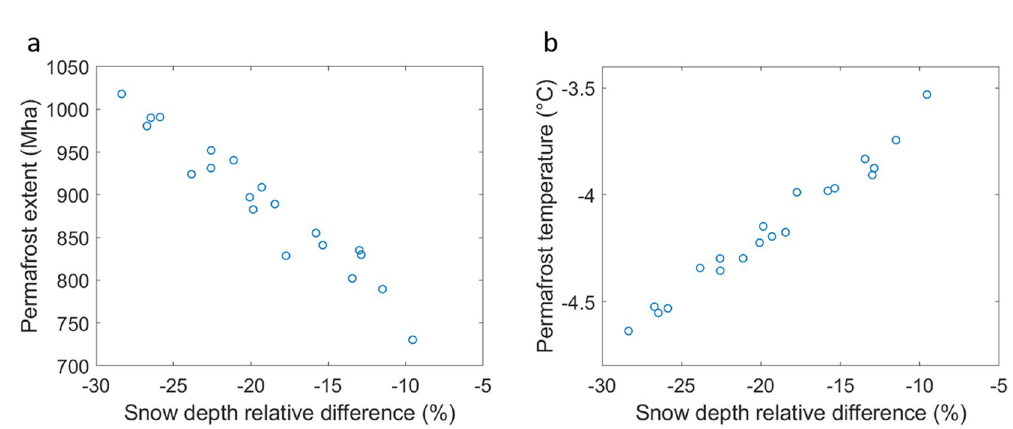
Figure 6. Sensitivity study mean areal results of permafrost extent ( a ) and permafrost temperature ( b ) as a function of percent snow depth difference to the CNTL model run for the period